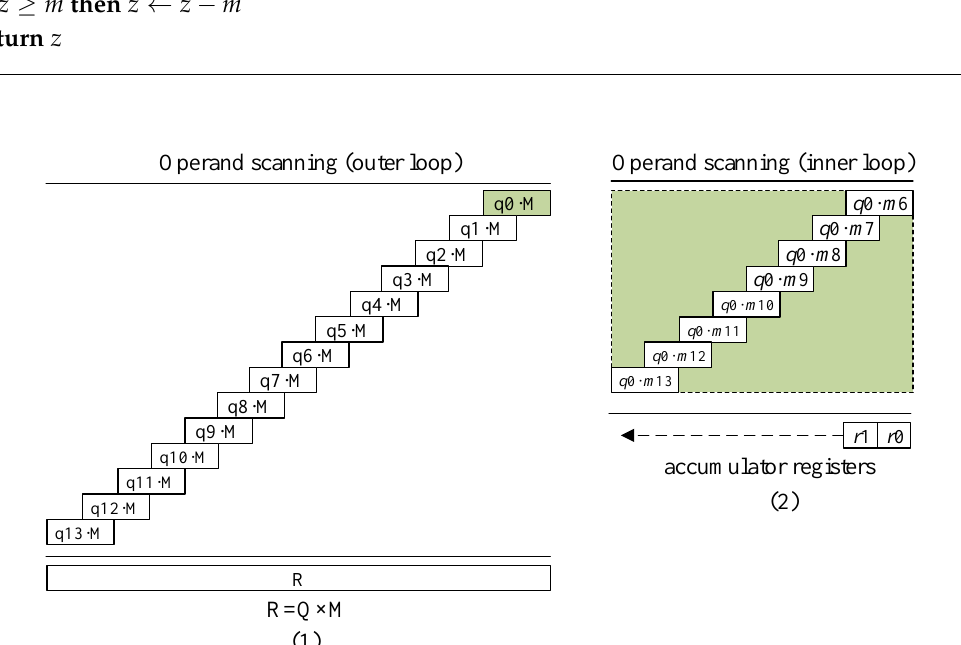
Figure 4. Proposed operand scanning multiplication for Montgomery reduction. Left part : outer loop, an example of SIKEp434. Right part : inner loop, ( q 0 · M